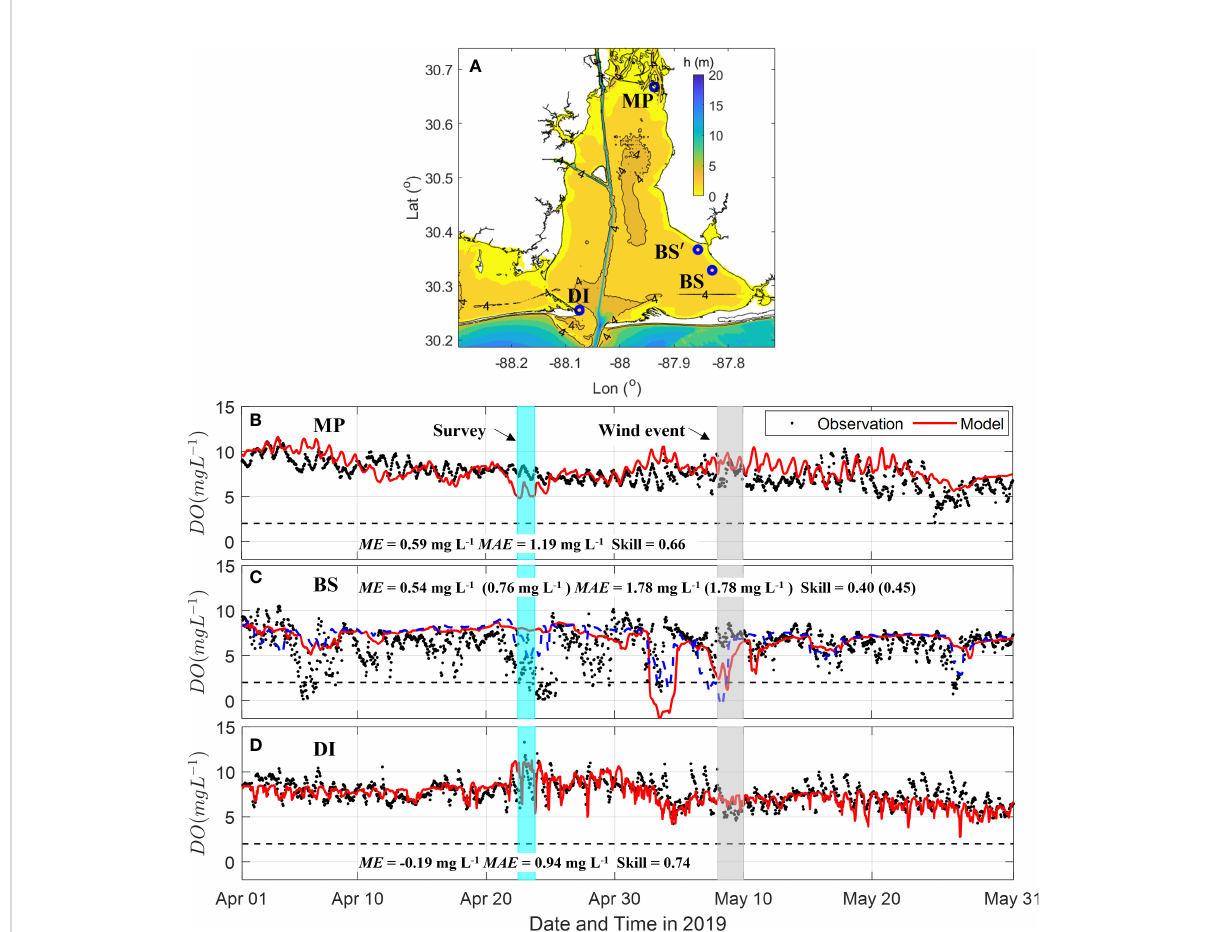
FIGURE 3 Time-series of hourly dissolved oxygen (DO) concentration at 0.5 m above bottom during April-May from ARCOS observation and model results. (A) Map of ARCOS stations at Meaher Park (MP), Dauphin Island (DI), and Bon Secour (BS and BS ’ ). Next are DO concentration time- series for each of those stations: (B) MP (C) BS and BS ’ (blue dashed line). BS ’ is a virtual station 4.9 km northwest of real observation station. (D) DI. Black dashed lines denote hypoxia threshold of 2 mg L -1 . Box in cyan denotes bay-wide survey during April 22-23. Box in grey denotes the southeast wind event during May